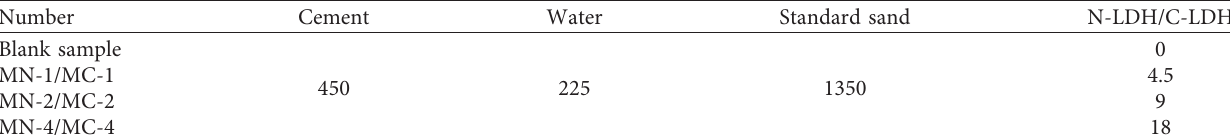
Table 4: Mortar mix ratio